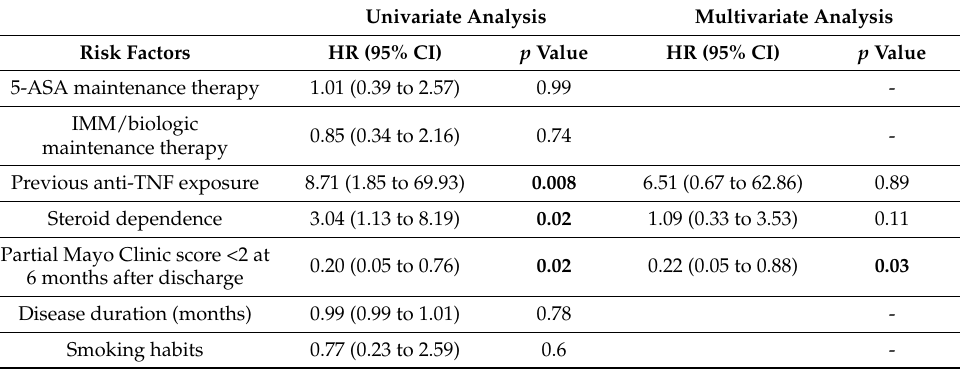
Table 4. Predictive variables associated with clinical relapse in 88 patients with acute severe ulcerative colitis responding to intravenous corticosteroids. IMMs = immunosuppressors. Significant value is in